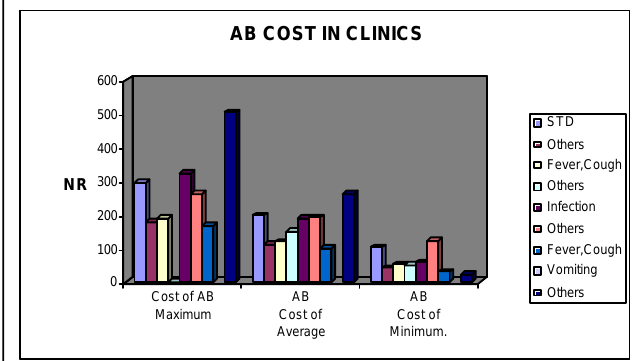
Fig. 6a : Showing pharmaco-economics of ABs treatment in all health problems in clinics (cost in NRs.)